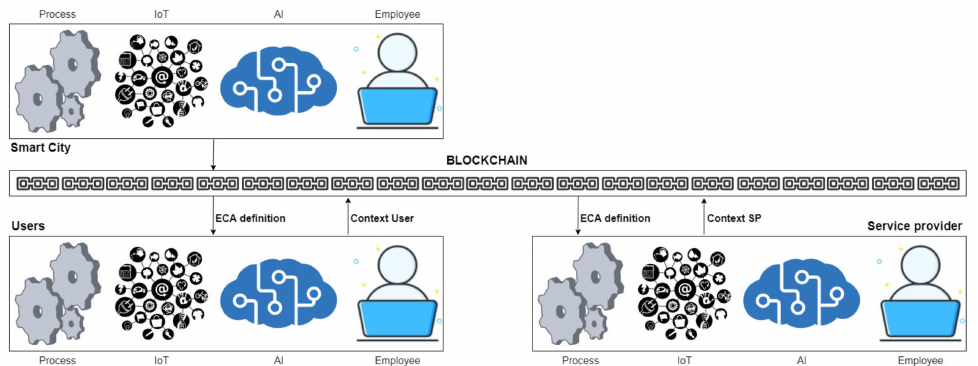
Figure 7. The ECA model and blockchain